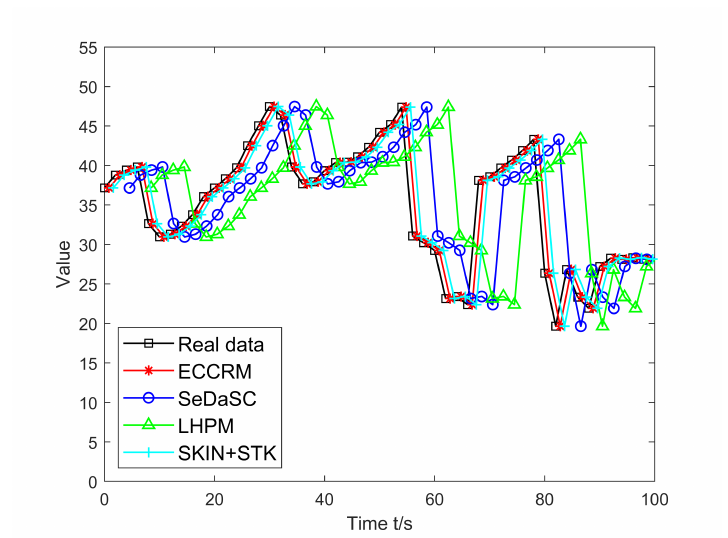
Figure 7. Comparison of search results for hot entities from cloud and edge servers.